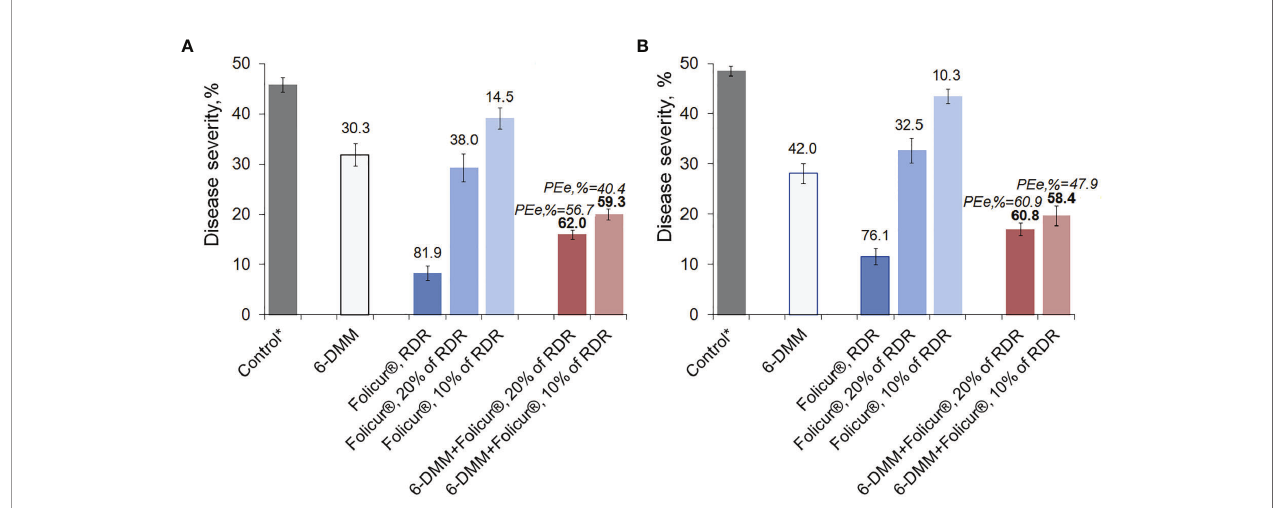
FIGURE 6 | Levels of disease development on wheat plants (cv. Khakasskaya) infected by a highly pathogenic strain (B-8/47) of P. nodorum after plants were treated with Folicur ® EC 250, the sensitizer (6-DMM), or 6-DMM combined with Folicur ® . (A) Preventive treatments (plants treated with fungicide simultaneously with inoculation). (B) Curative treatments (plants sprayed with fungicide one day after inoculation). *Control — disease severity on non-treated plants after inoculation with P. nodorum B8/47 conidia (maximum score of leaf damage according to the James scale, 1971 is 50%). RDR = recommended dose rate. The numbers in bold or regular above the columns indicate PEr,%; values of Y-bars indicate SE with a 95% con fi dence interval ( n = 100, p = 0.05). For additional explanation, see Figure 5 and section “ Materials and Methods , ” point